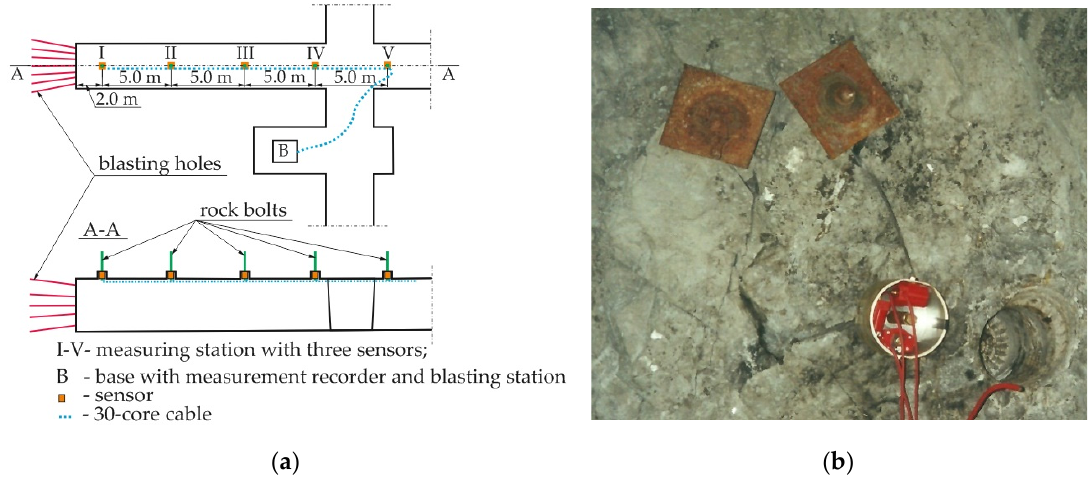
Figure 4. Test stand in the underground copper ore mine: ( a ) arrangement of measuring sensors; ( b ) a general view of the sensor installed in the roof of the room.